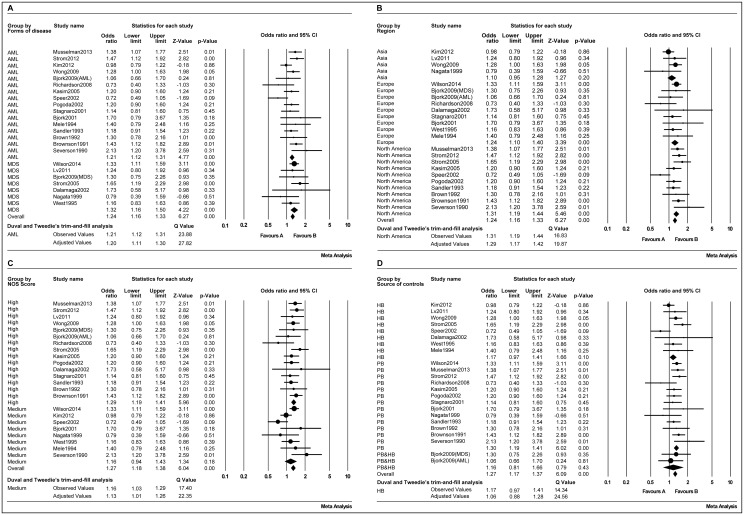
Forest plots of the risk of adult myeloid disease in ever-smokers.(A) Forms of disease, (B) geographical region, (C) NOS score (high and medium quality), (D) source of controls.